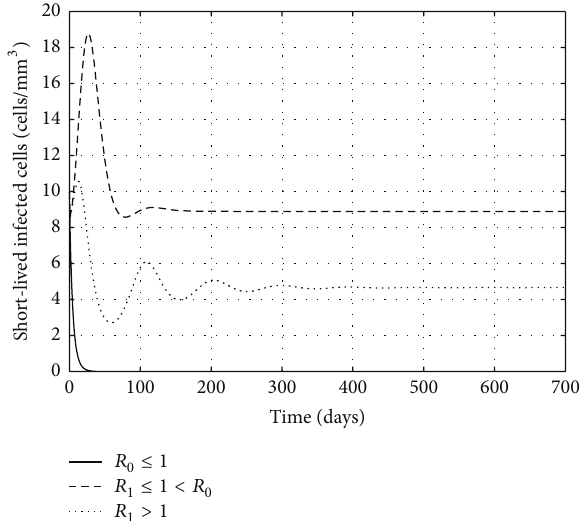
Figure 4: The concentration of free virus particles for model